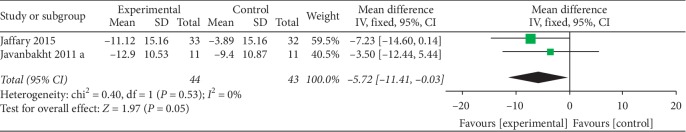
Forest plot of the meta-analysis of vitamin E and atopic dermatitis.